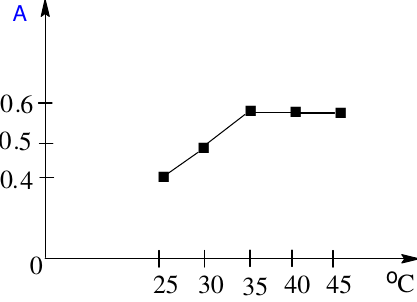
Figure 4. Effect of temperature on the development of the complex of MPT (20 µ g/mL) with